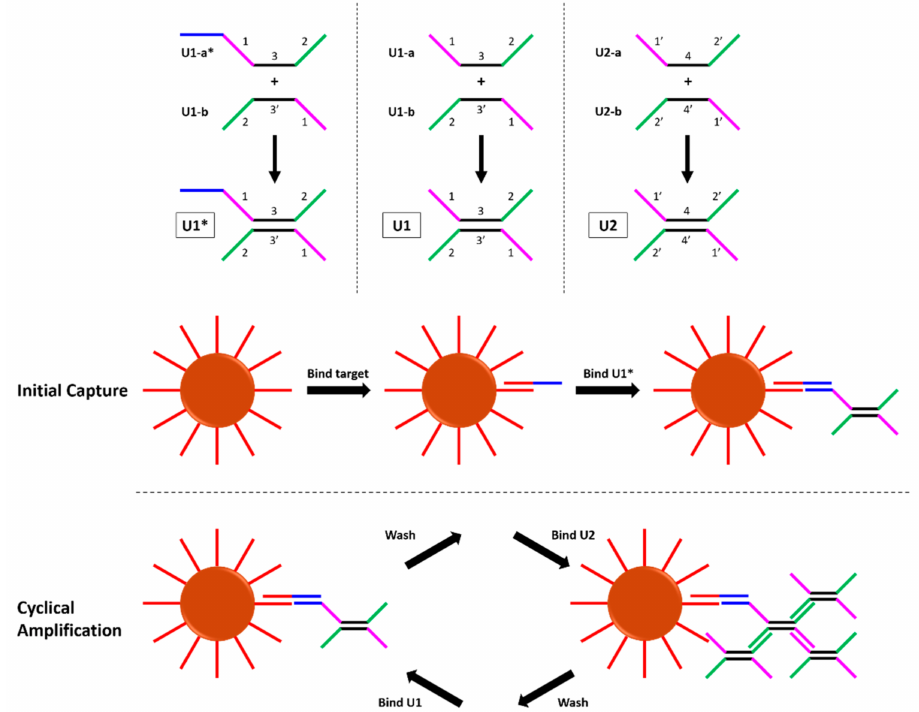
Figure 1. Overview of the dumbbell amplification assay. ( Top ) The DNA dumbbells used in this study. Complementary binding domains are denoted as 1, 1 (cid:48) . ( Bottom ) Binding steps in the dumbbell amplification assay. After binding target and U1*, the beads cycle between incubations of U1 and U2, with intermediate wash